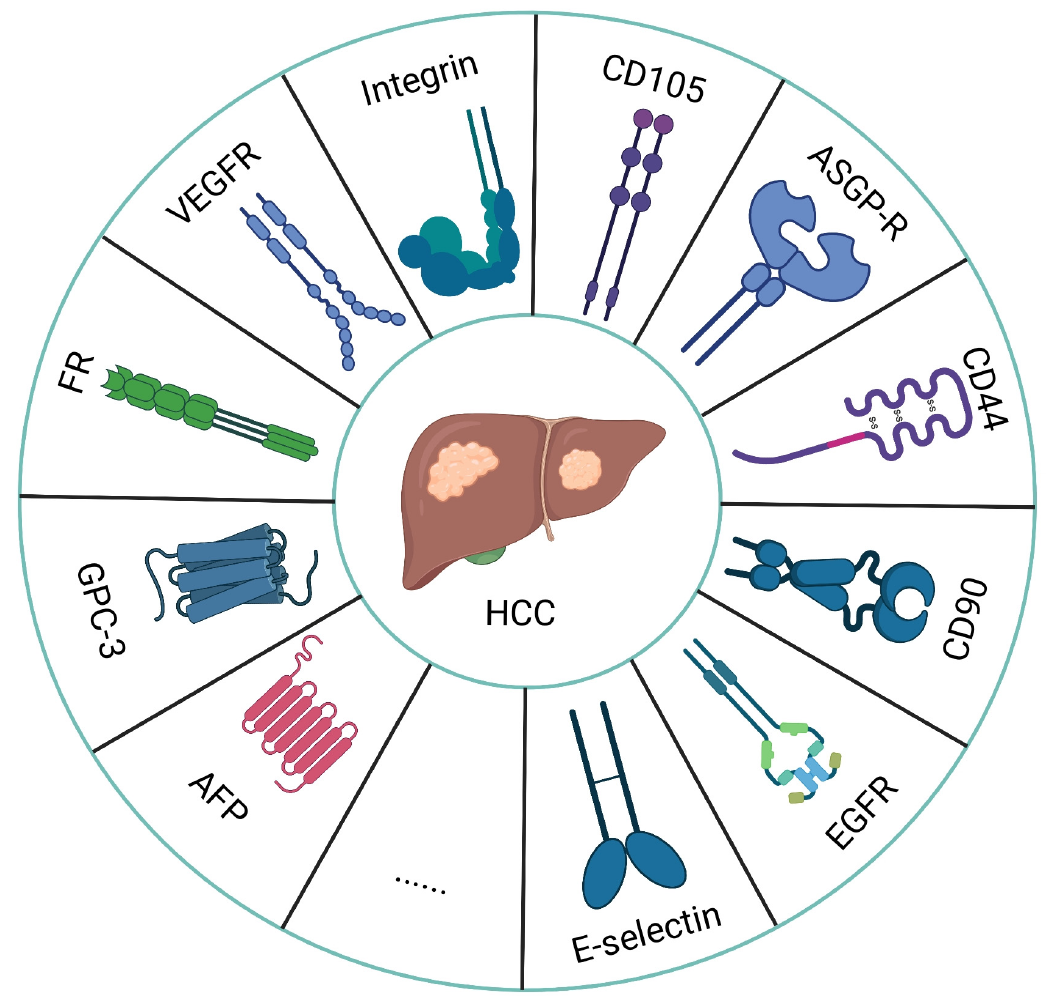
Figure 2. The above is a list of the receptors that are overexpressed in HCC